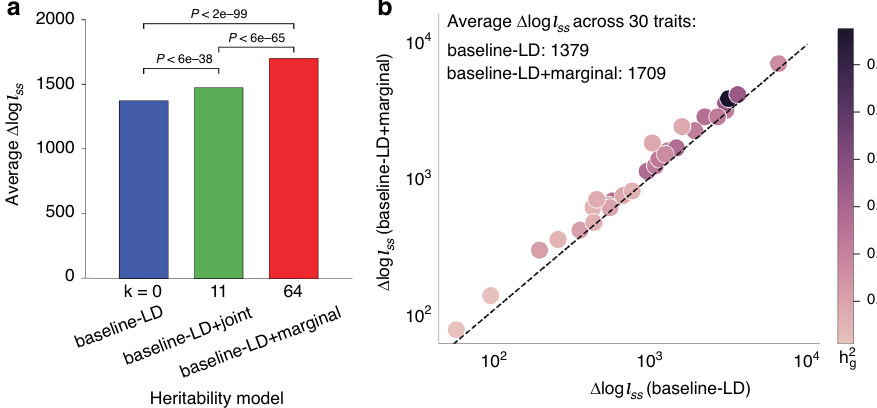
Fig. 5 Evaluation of improvement in heritability model fi t. We report ( a ) average Δ log l SS (an approximate model likelihood metric 57 ) across 30 UKBB traits; b Δ log l SS of the baseline-LD and baseline-LD + marginal models for each trait. Δ log l SS is computed as log l SS of a given model - log l SS of a model with no functional annotations (baseline-LD-nofunct model: MAF/LD annotations only). In ( a ), k denotes the number of new annotations beyond the baseline- LD model. Numerical results are reported in Supplementary Data